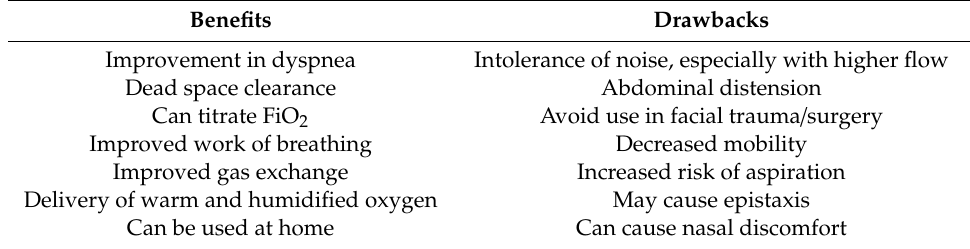
Table 2. Benefits and drawbacks of